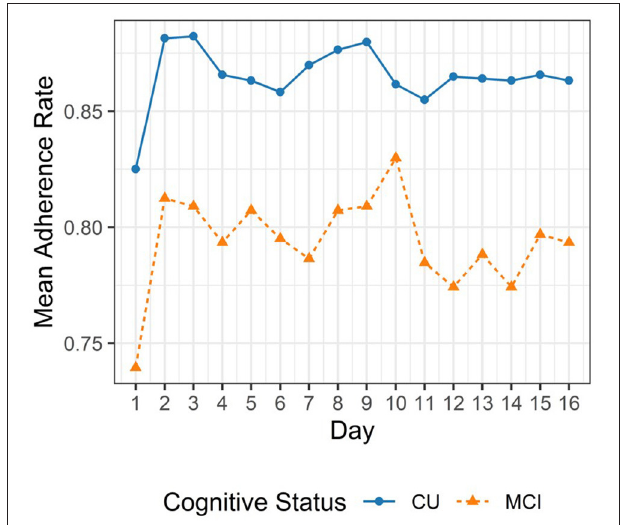
FIGURE 3 | Mean adherence to EMA